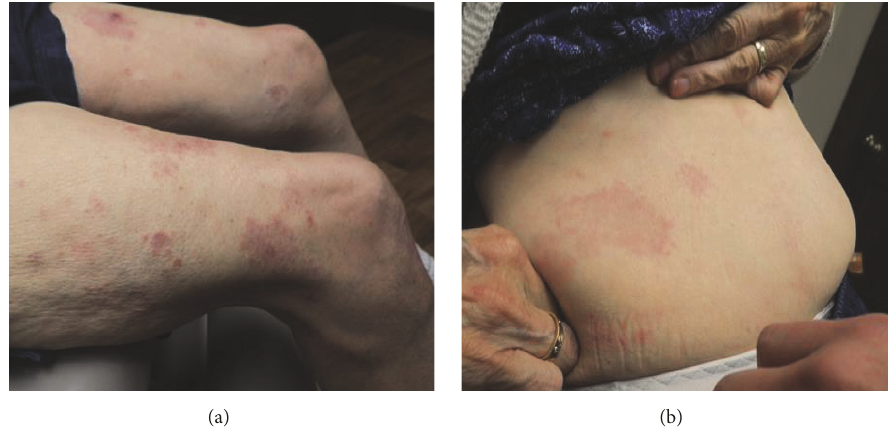
Figure 1: Patient’s presentation with a new eruption in June 2017.